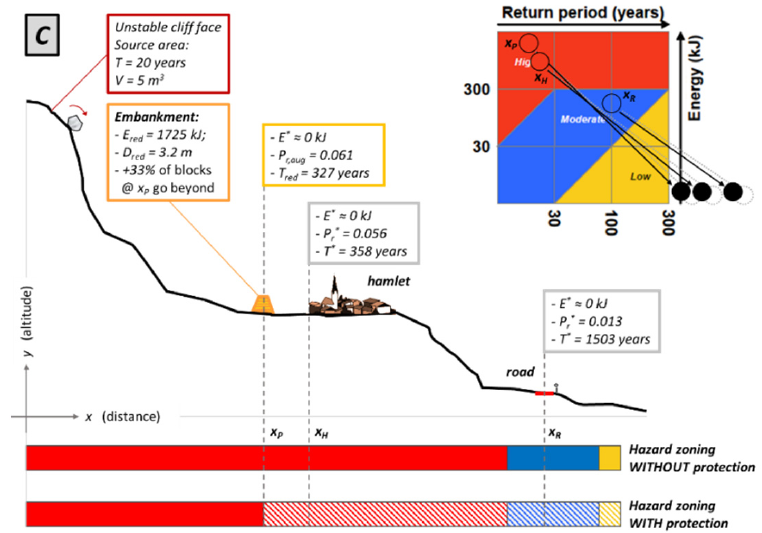
Figure 5. Example 2: hazard zoning obtained along the slope based on the presence of an earth embankment in the rock fall propagation zone. ( A ) Hazard zoning without embankment. ( B ) Hazard zoning with embankment in optimal working order. ( C ) Hazard zoning with embankment with reduced performance capacity. The mitigation effects at each location of interest are illustrated with reference to the Swiss rock fall intensity–frequency diagram.